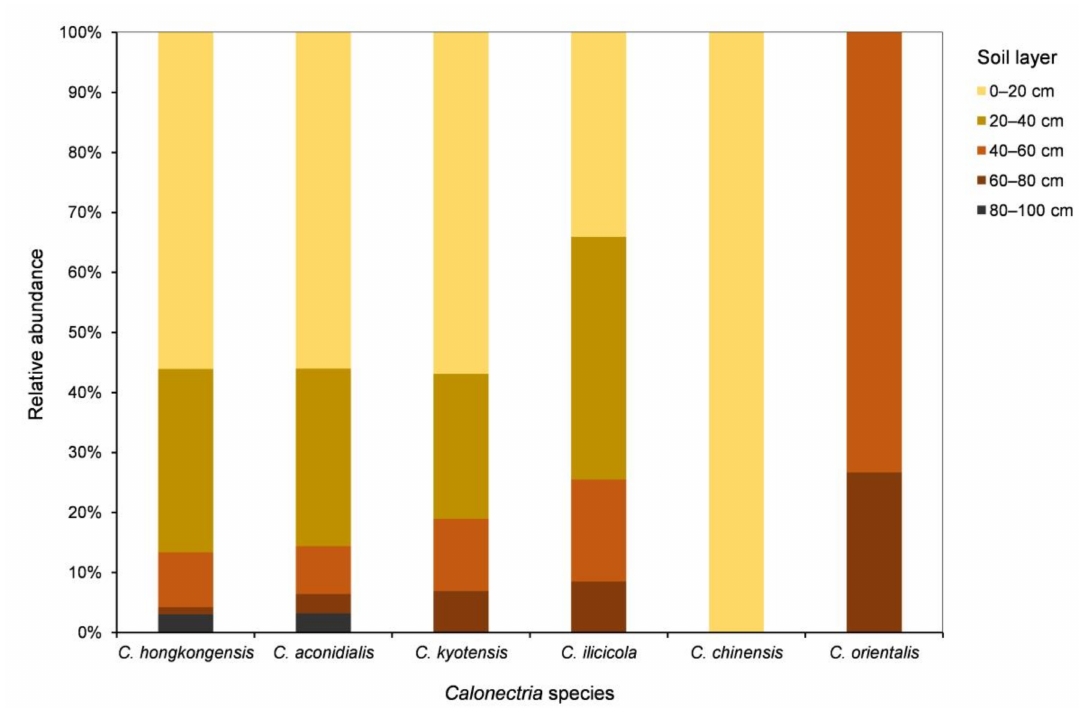
Figure 5. Relative abundances of each Calonectria species in each of the five soil layers. Relative abundance was based on the proportional frequencies of isolates of each Calonectria species in each soil